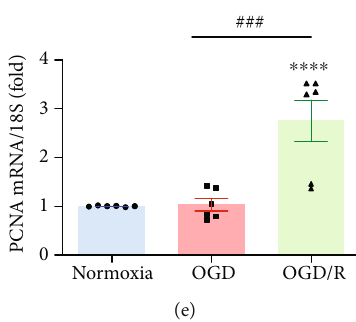
Figure 2: E ff ects of OGD and reoxygenation (OGD/R) in hippocampal cell cultures. ( a) Time course schematic representation of OGD and reoxygenation (OGD/R) experimental conditions. (b) Representative immuno fl uorescence images showing e ff ects of incubation conditions upon cultured hippocampal cells exposed to (i) normoxia, (ii) OGD, or (iii) OGD/R. Cell nuclei were stained with DAPI (blue) and neurons with anti-DCX (green) and anti- β -III-tubulin (red), and the images were merged. Scale bar: 50 μ m. (c) Cell survival was evaluated by the MTT assay in each experimental group. (d) Quanti fi cation of cell nuclei stained with DAPI from each experimental group. (e) The expression of PCNA mRNA was analyzed by RT-qPCR. Relative mRNA expression values were corrected by the comparative threshold cycle (Ct) method and employing the formula 2 − ΔΔ CT . Ribosomal 18S RNA was used as housekeeping gene. Bars represent mean ± SEM . Asterisks ( ∗ ) indicate signi fi cant di ff erences in comparison to control ( ∗∗∗ p < 0 : 001 ; ∗∗∗∗ p < 0 : 0001 ), and number sign (#) shows di ff erences between experimental groups ( ### p < 0 : 001 ; #### p < 0 : 0001 ) as assessed by one-way ANOVA and Tukey as posthoc